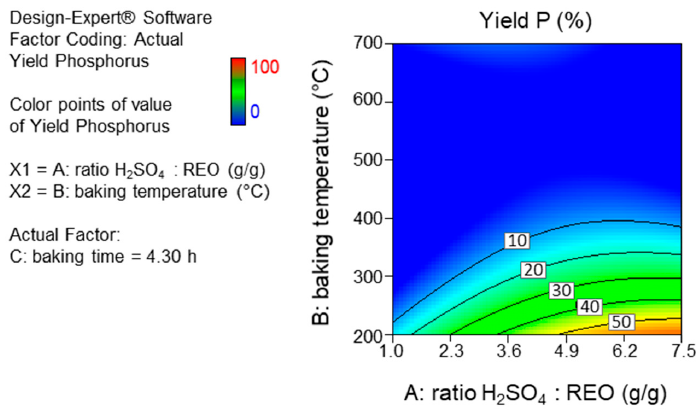
Figure 13. Perturbation plot for the response “Yield Th.”